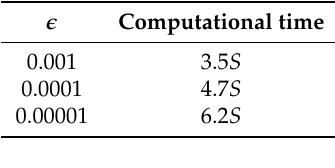
Table 4. Computational time.